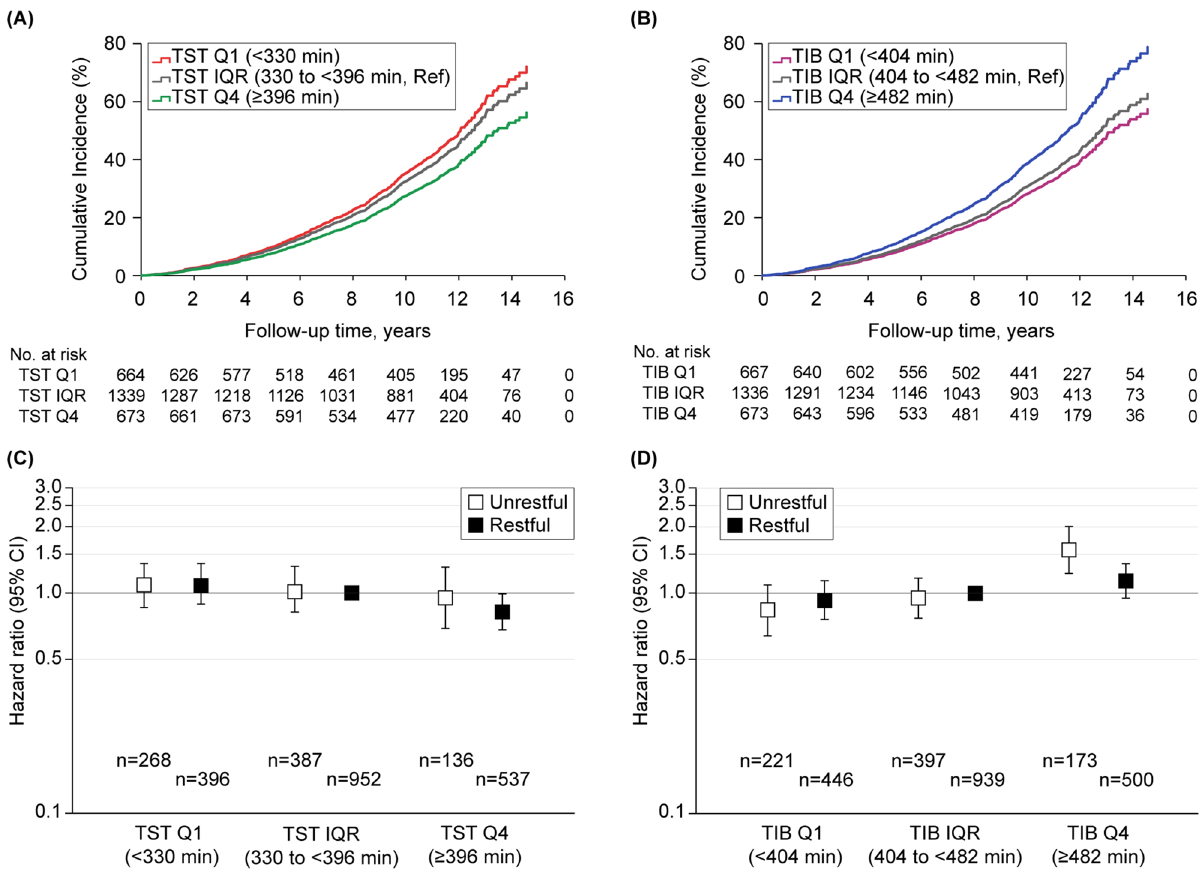
Figure 2. Adjusted Cox regression plots by total sleep time, time in bed, and sleep restfulness for older adults. Differential cumulative incidences or hazard ratios from the fully adjusted Cox proportional hazard models (Model 3) are shown for older adults: ( A ) cumulative incidences by TST quartiles; ( B ) cumulative incidences by TIB quartiles; ( C ) hazard ratios by TST quartiles with sleep restfulness; and ( D ) hazard ratios by TIB